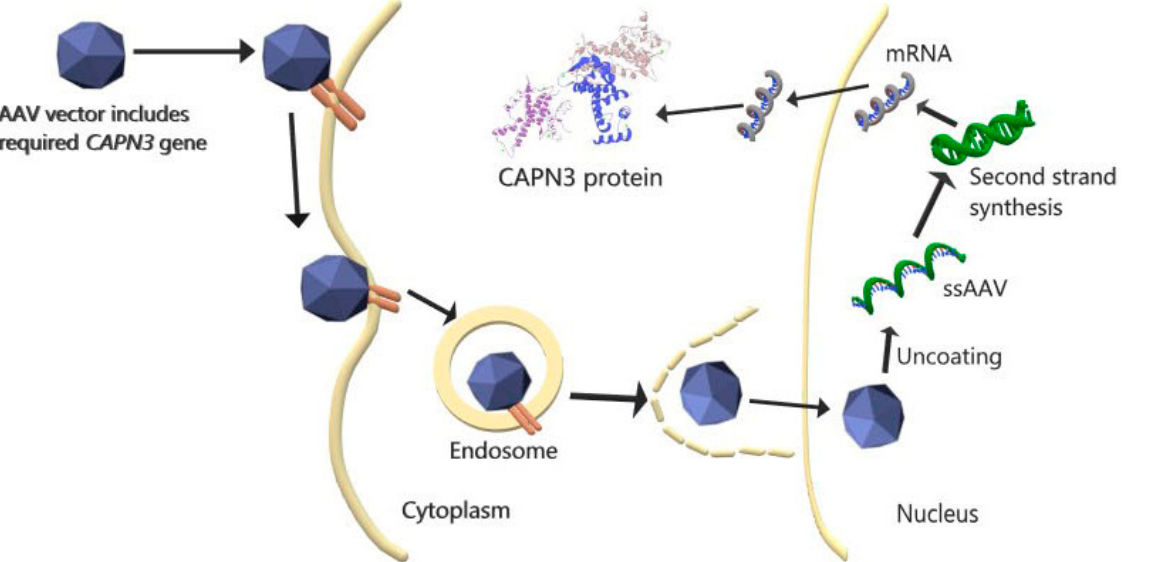
Figure 1. AAV-mediated CAPN3 gene therapy. rAAV, containing the desired CAPN3 gene, binds to the appropriate receptor and enters the cell via the endosome. AAV enters the nucleus after escaping from the endosome in the cytoplasm. After the AAV enters the nucleus and separates it from its capsid, the single-stranded (ss) DNA is transformed into double-stranded DNA, and the desired CAPN3 mRNA is transcribed by the cell. The mRNA, when leaving the nucleus and entering the cytoplasm, is translated into the CAPN3 protein [38].